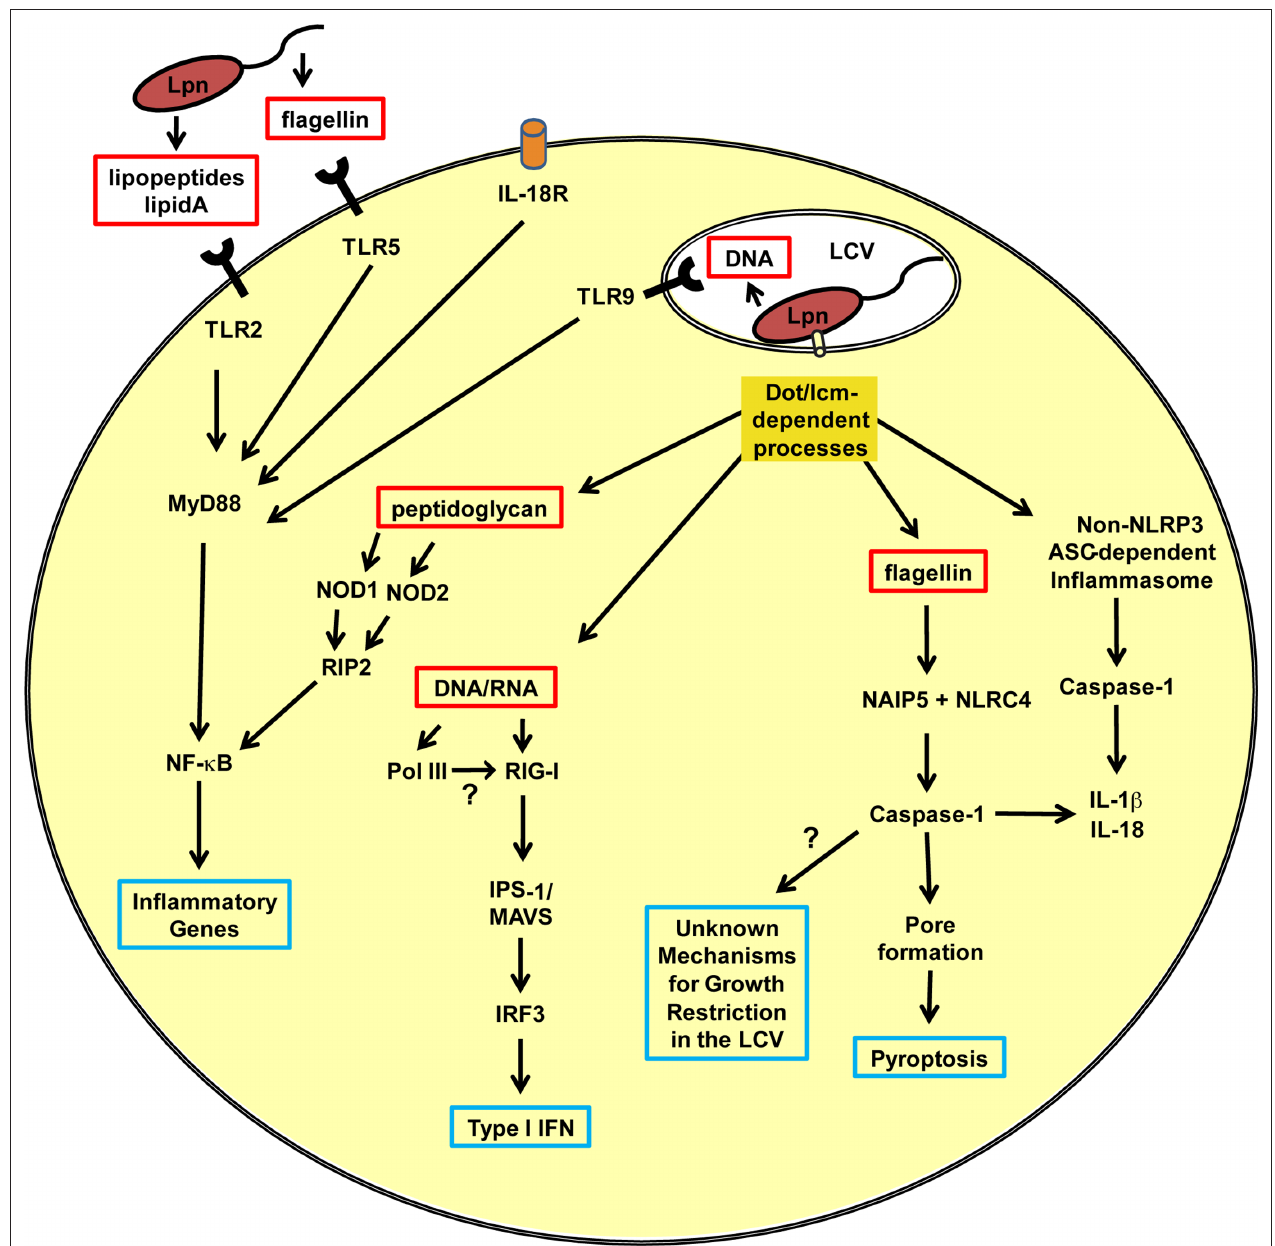
Figure 1 | innate immune responses of a mammalian phagocyte infected with Legionella pneumophila . A schematic representation of the pathways activated in a phagocyte after infection with L. pneumophila . The red boxes indicate L. pneumophila -associated molecular patterns important for the activation of pattern recognition receptors. Blue boxes indicate molecules or processes involved in the cell-autonomous restriction of L. pneumophila replication. LCV, Legionella - containing vacuole; Lpn, L. pneumophila ; Dot/Icm, type IVB secretion system;